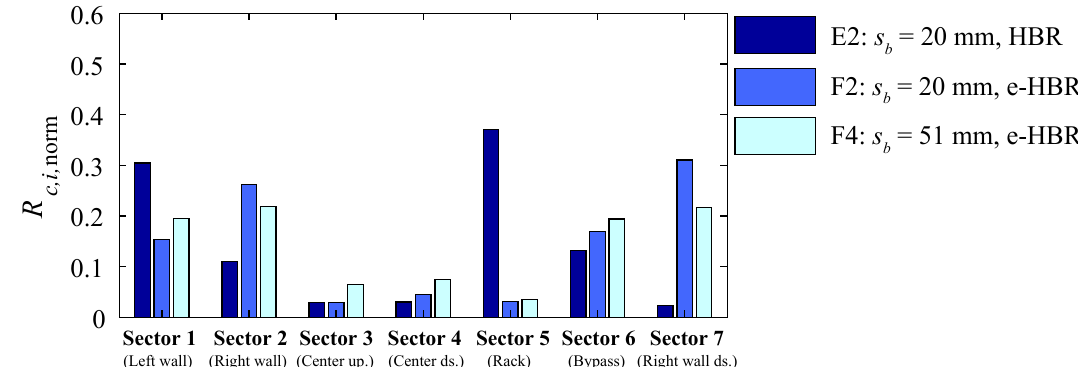
Figure 10. Normalized residence coefficient R c , i , norm of eels ( Anguilla anguilla ) for sectors 1–7 with and without electrification for different s b